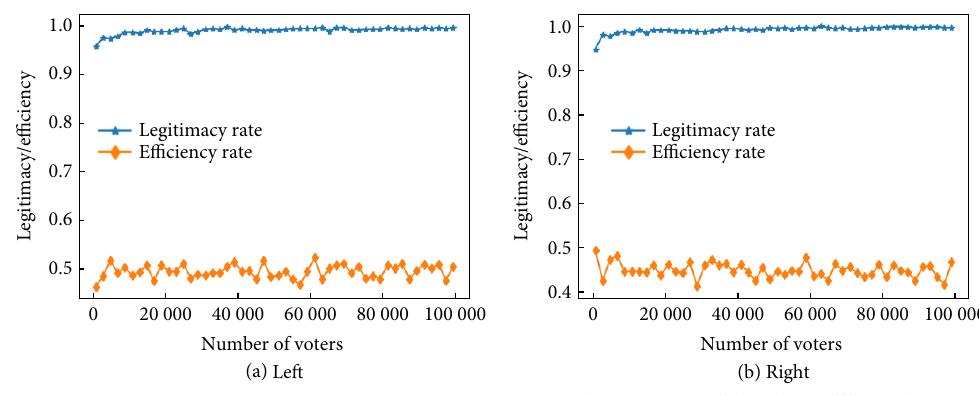
Fig. 12 Change curves of legitimacy/effciency when the numbers of candidates are 5 ((a) Left) and 6 ((b) Right).